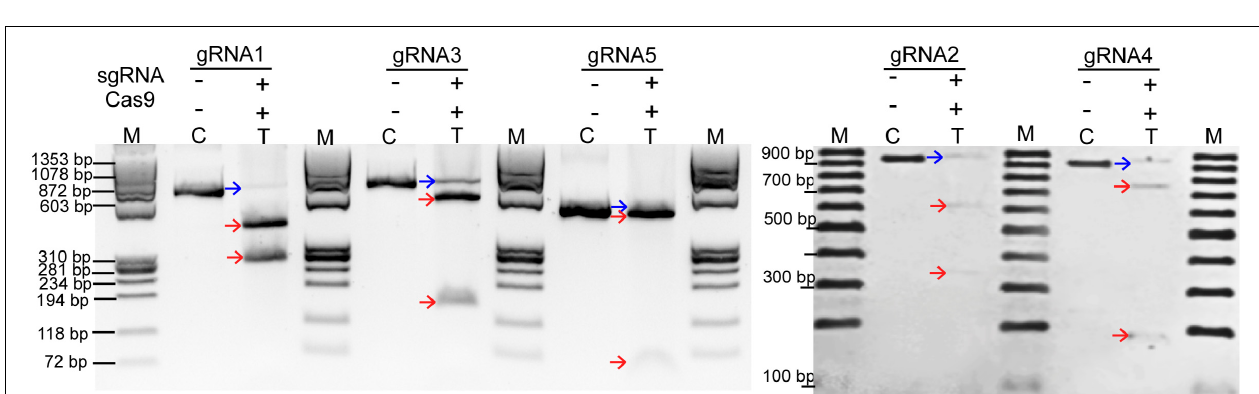
FIGURE 4 | Cellular localization of GFP-Cas9 RNP complexes in transfected protoplasts from Glycine max cv Bayfield. (A,D) Confocal fluorescence microscopy showing GFP-Cas9 located inside transfected protoplasts using the green channel. White arrows indicate internalized localization of GFP-Cas9. (B,E) The same protoplasts as depicted in (A,D) showing bright-field images using the ESID channel. (C,F) Are overlay images of green and ESID channels. White arrows indicate internalized localization of GFP-Cas9.